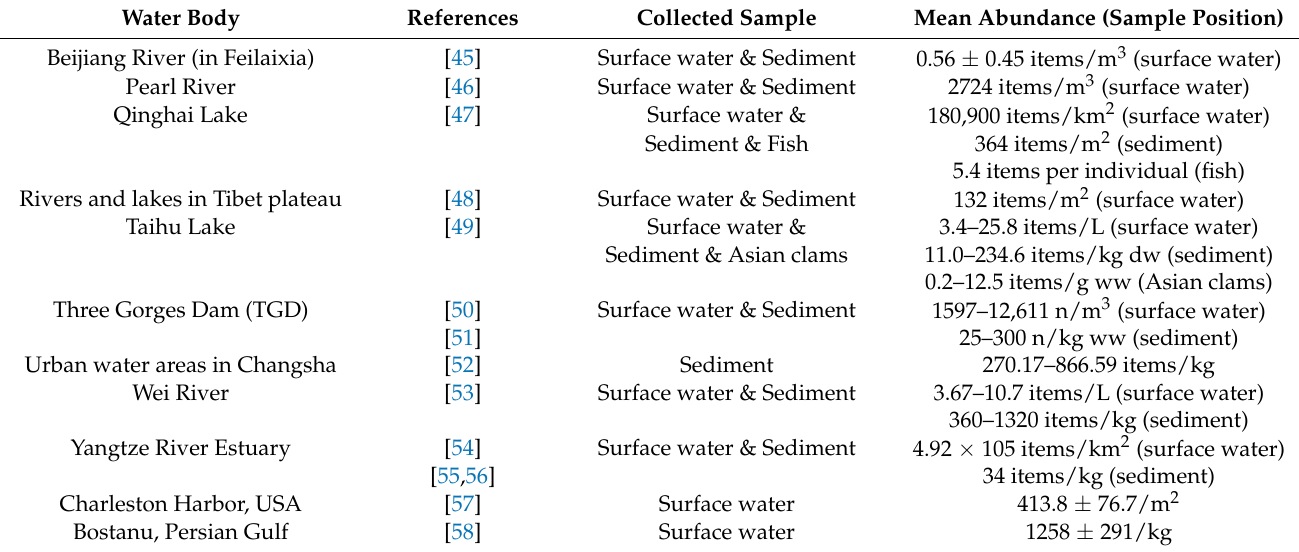
Table 1. Studies on detecting microplastics in inland water